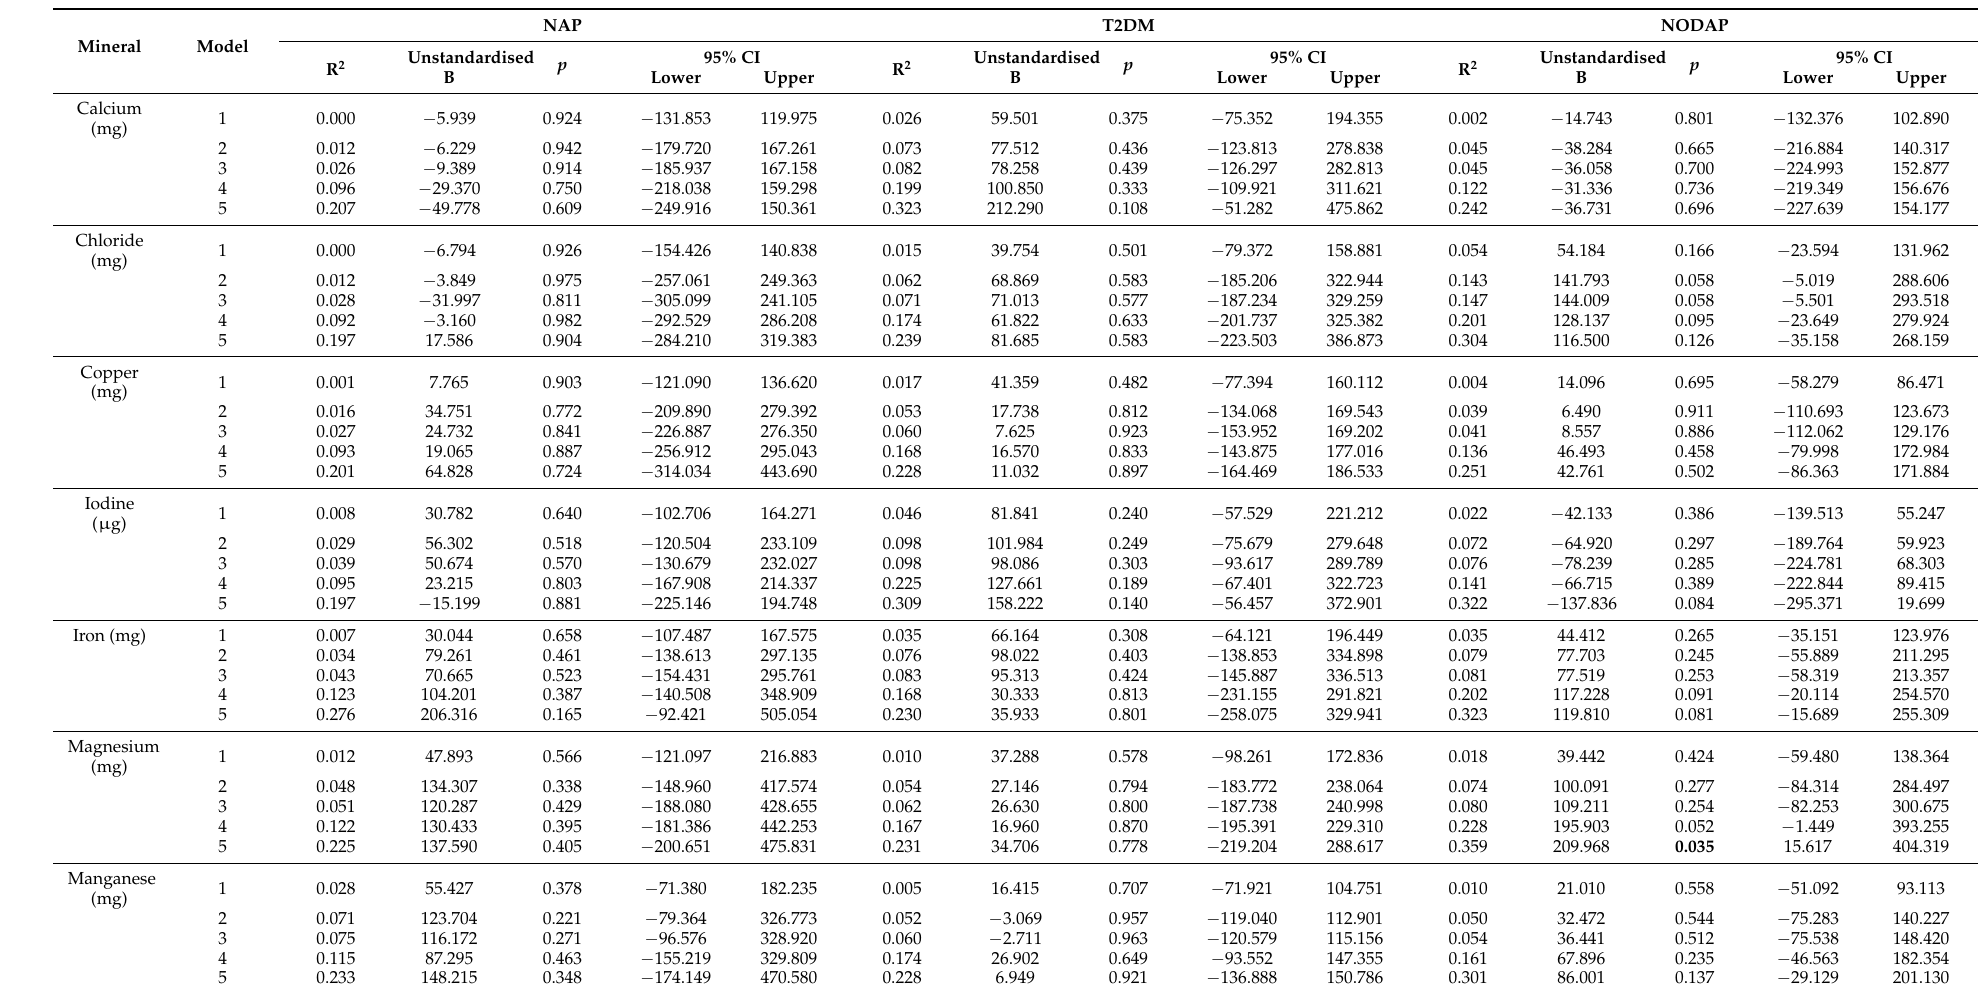
Table 7. Associations between habitual mineral intake and HOMA- β in the study